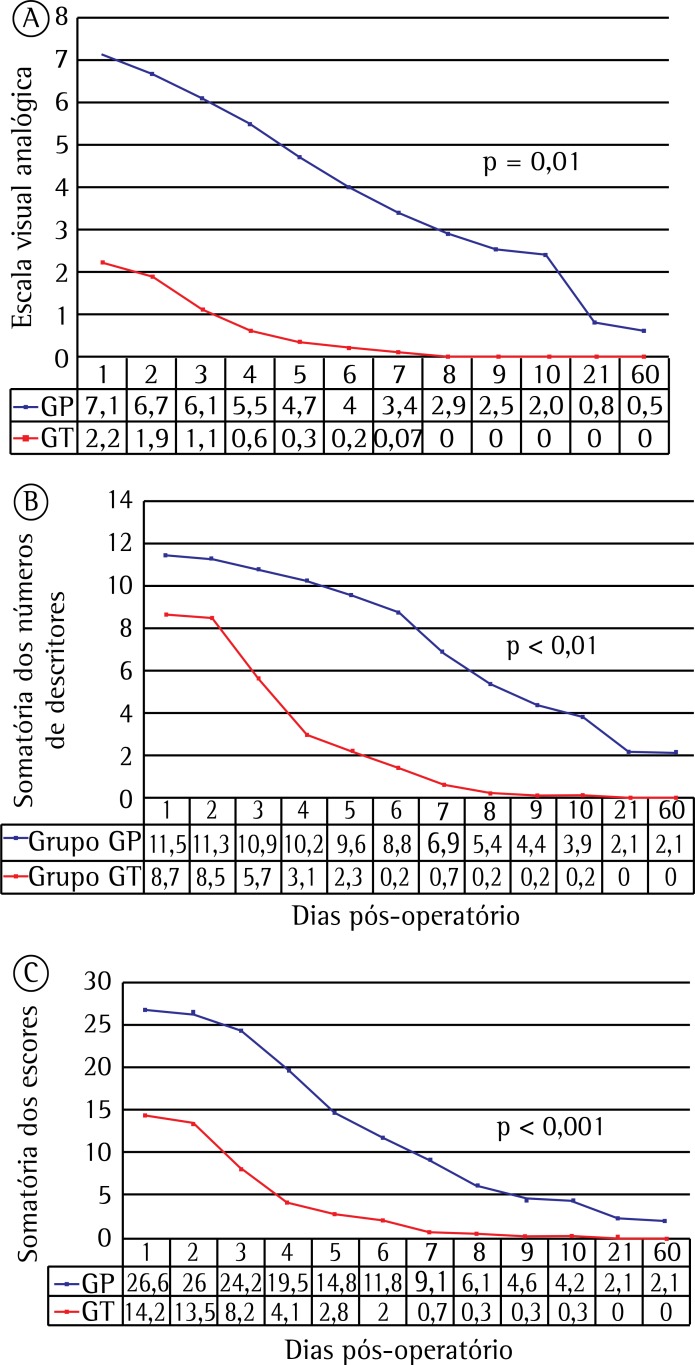
Comparação da média da avaliação da intensidade da dor em diversos dias
pós-operatórios nos grupos pericostal (GP) e transcostal (GT). Em A, escala
visual analógica. Em B, somatória dos números de descritores selecionados
pelos pacientes no questionário de dor McGill. Em C, somatória dos escores
pelo questionário de dor McGill.